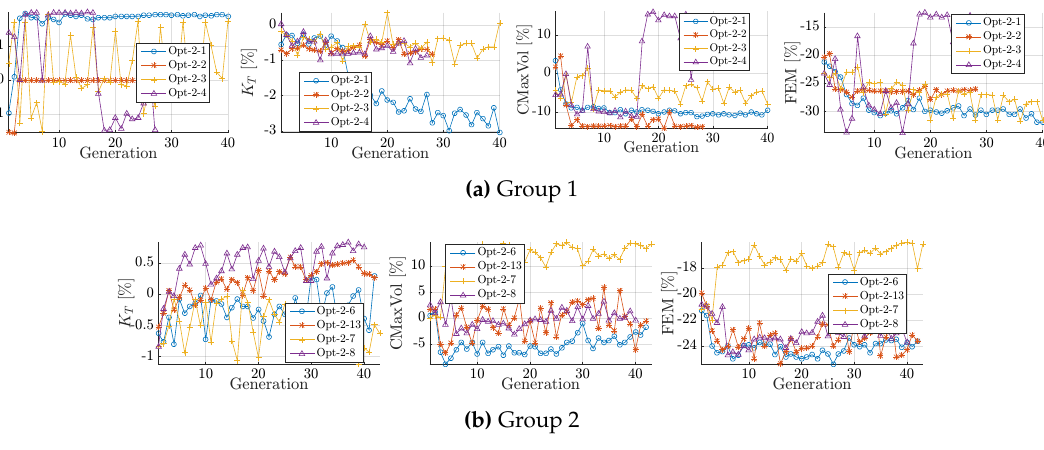
Figure 8. Development of constraints in Group 1 ( a ); and Group 2 ( b